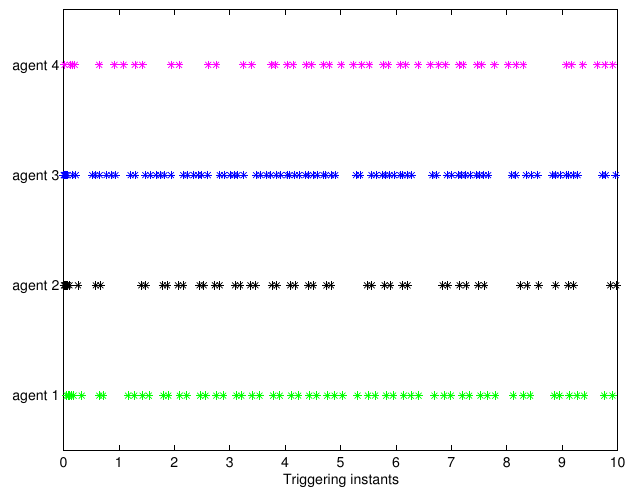
Figure 4. Triggering instants of MAS (42) with state-based algorithm.